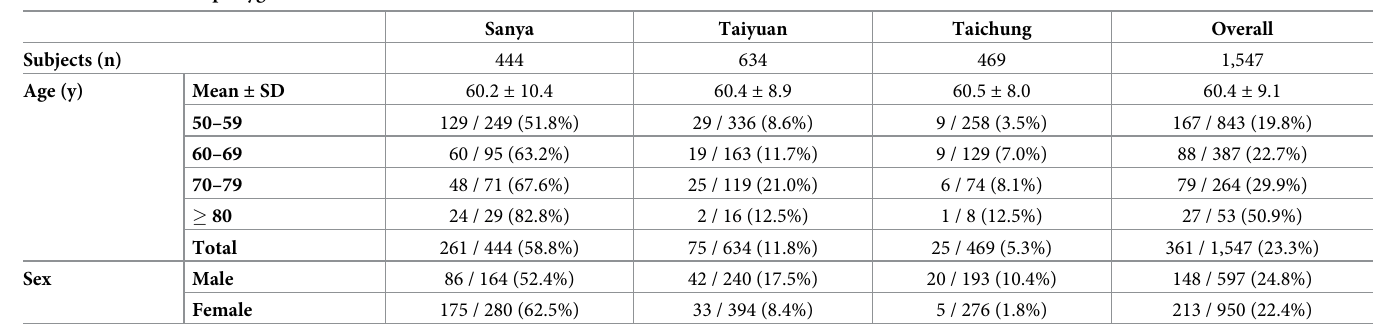
Table 2. Prevalence of pterygium.